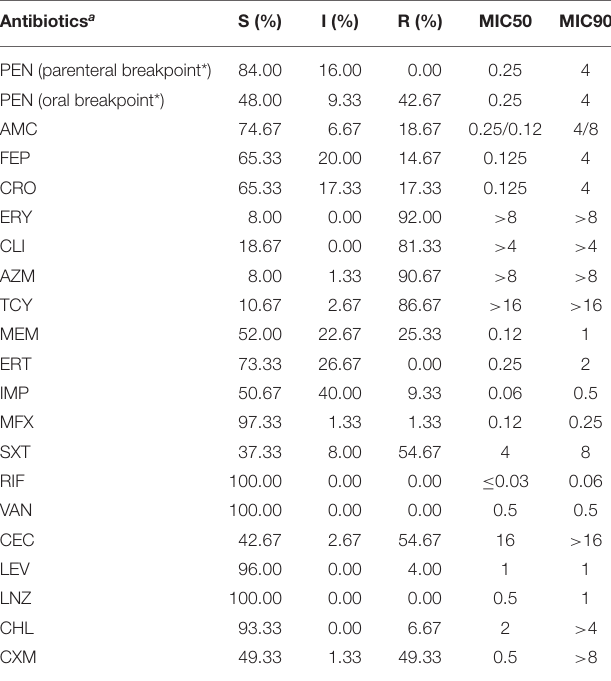
TABLE 3 | Antimicrobial susceptibility of 75 S. pneumoniae isolates to 20 antimicrobial agents. Antibiotics